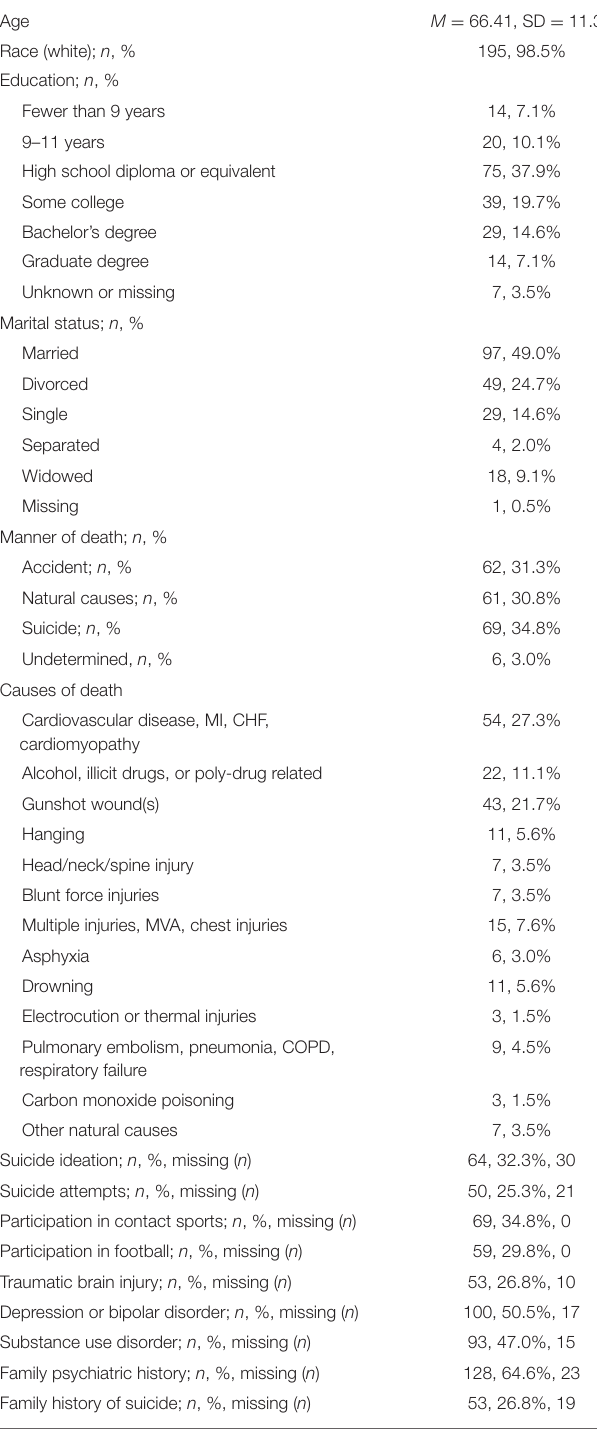
TABLE 1 | Characteristics of the